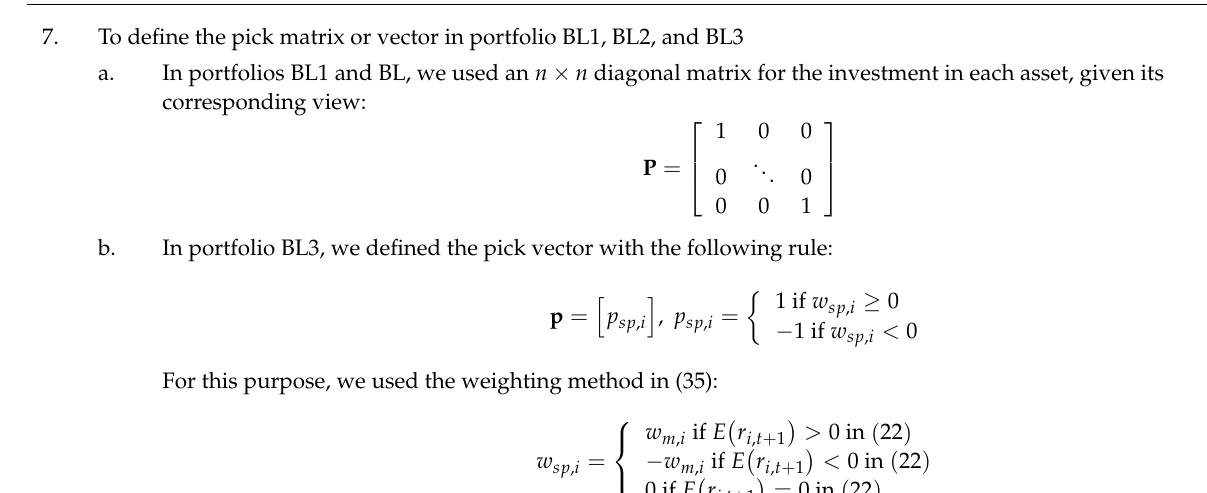
Algorithm 1: The steps followed in the portfolio simulation of BL1, BL2, BL3, and